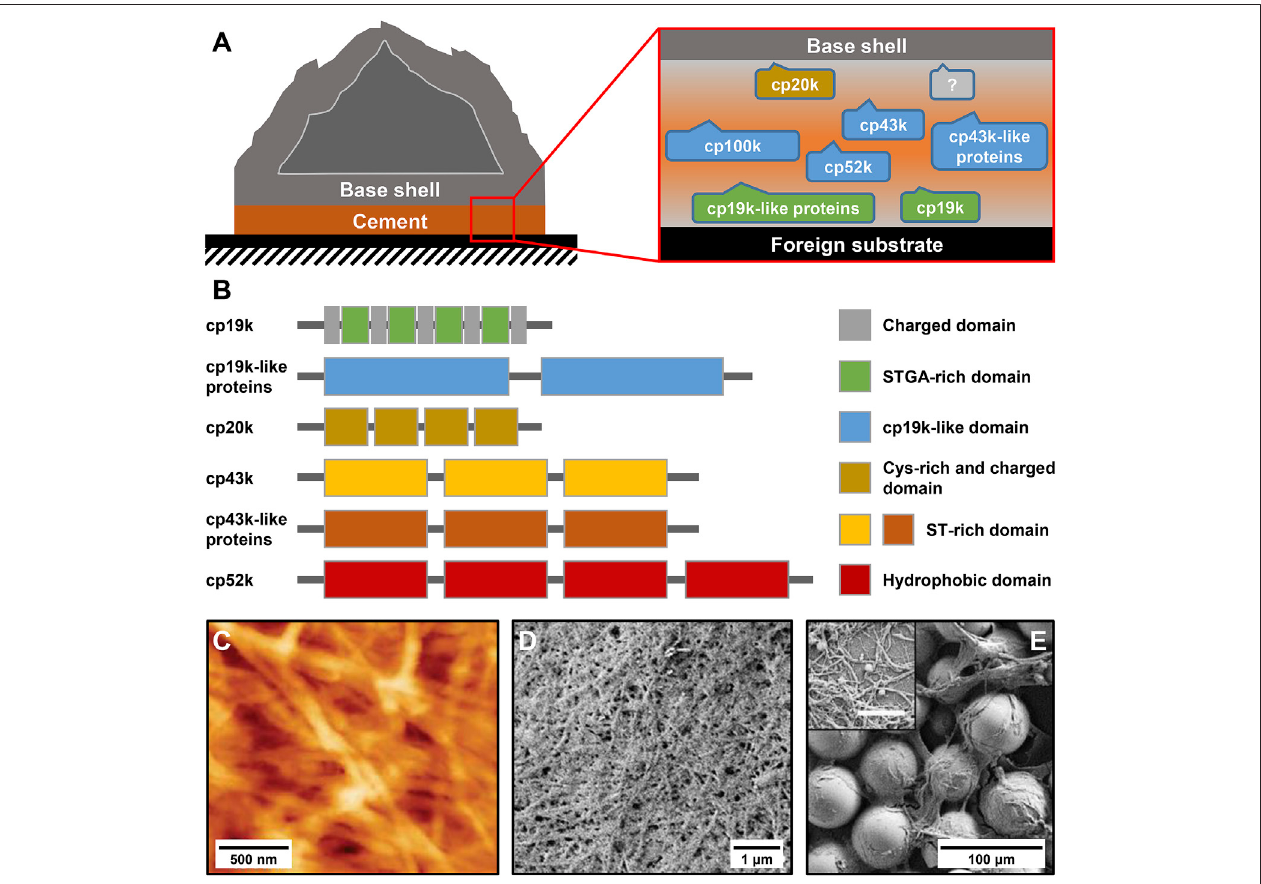
FIGURE1| Proteincompositionandmicroscalestructureofbarnaclecement. (A) Schematicdiagramofanadheredacornbarnacleandtheproteincompositionof its cement. (B) Sequence characteristics of different BCPs. (C) Atomic force microscope (AFM) image of Amphibalanus amphitrite cement. Scanning electron microscope(SEM)imageof A.amphitrite cementattachedto (D) siliconepanelsand (E) glassbeads. Theinsetin (E) showsmagni fi edcementnano fi bers.Thescalebar is 500 nm. (C) Adapted with permission from Barlow et al. (2010). Copyright 2010, American Chemical Society. (D,E) Adapted from So et al.